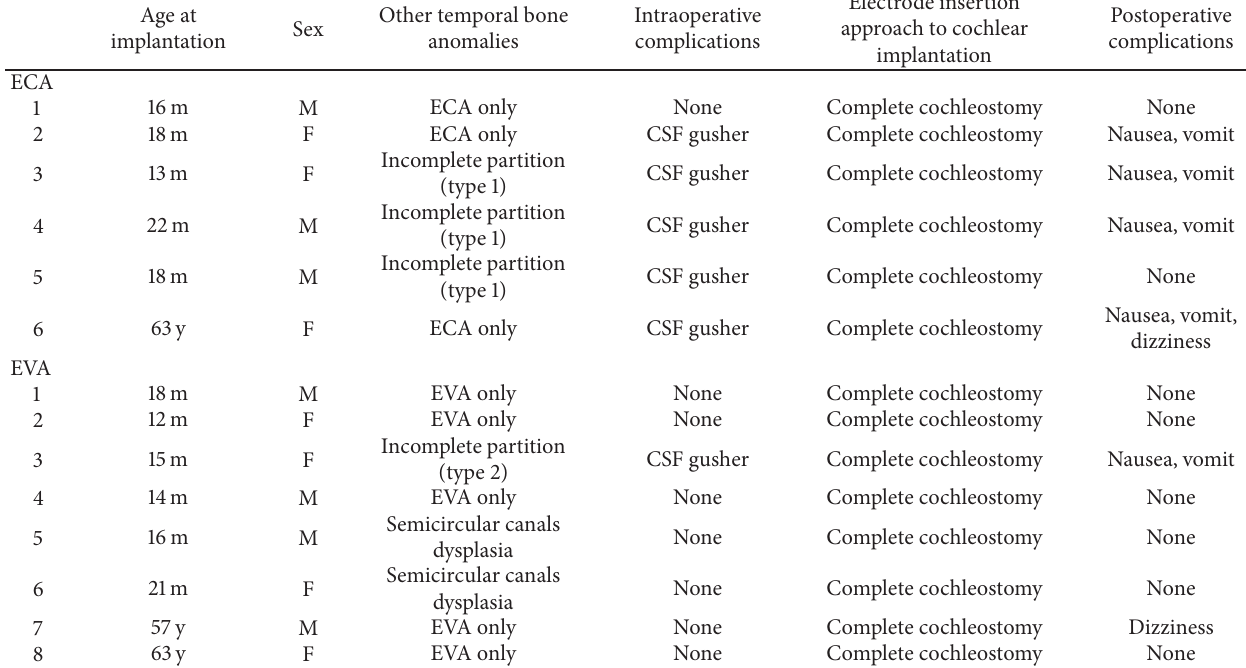
Table 1: Features of ECA and EVA